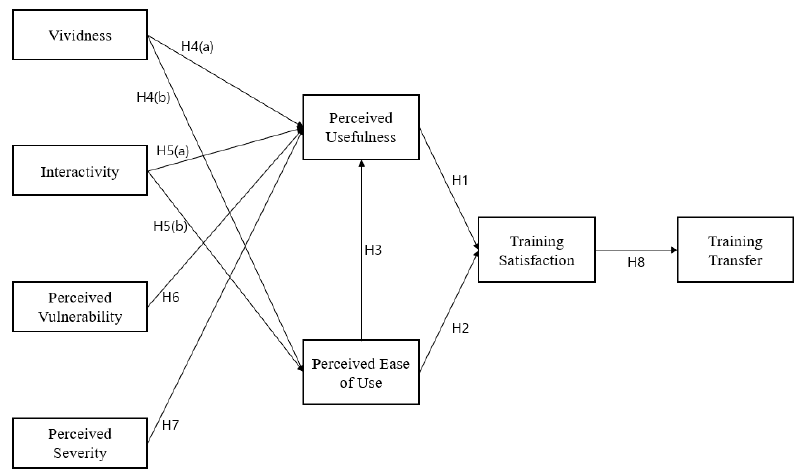
Figure 1. Proposed Research Model.